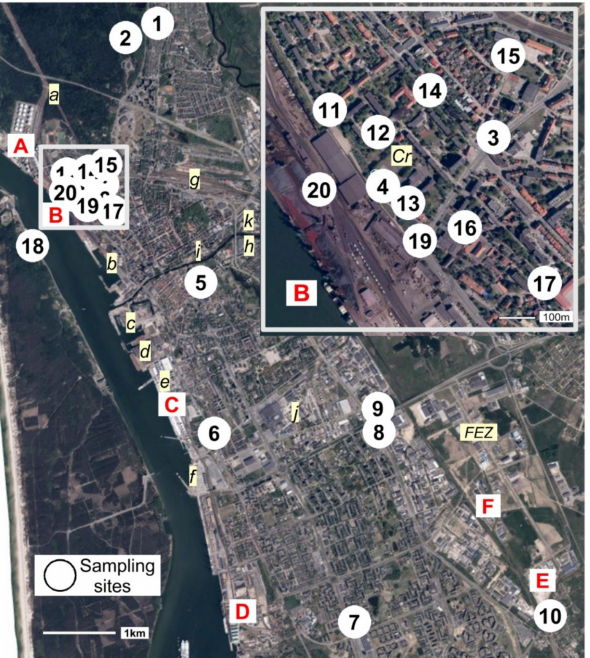
Figure 1. Location of TSP sampling sites (their identification number is in the circle) and potential sources of impact in Klaip˙eda port city. In the port area, the main stevedoring terminals are: A—bulk products loading (fertilizers: KCl, NH 4 NO 3 , (NH 2 ) 2 CO, etc.; grain: wheat, barley, etc.);